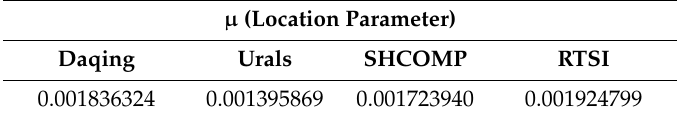
Table A18. MNIG Location parameter µ for Vector 5: Daqing, Urals, SHCOMP, RTSI.